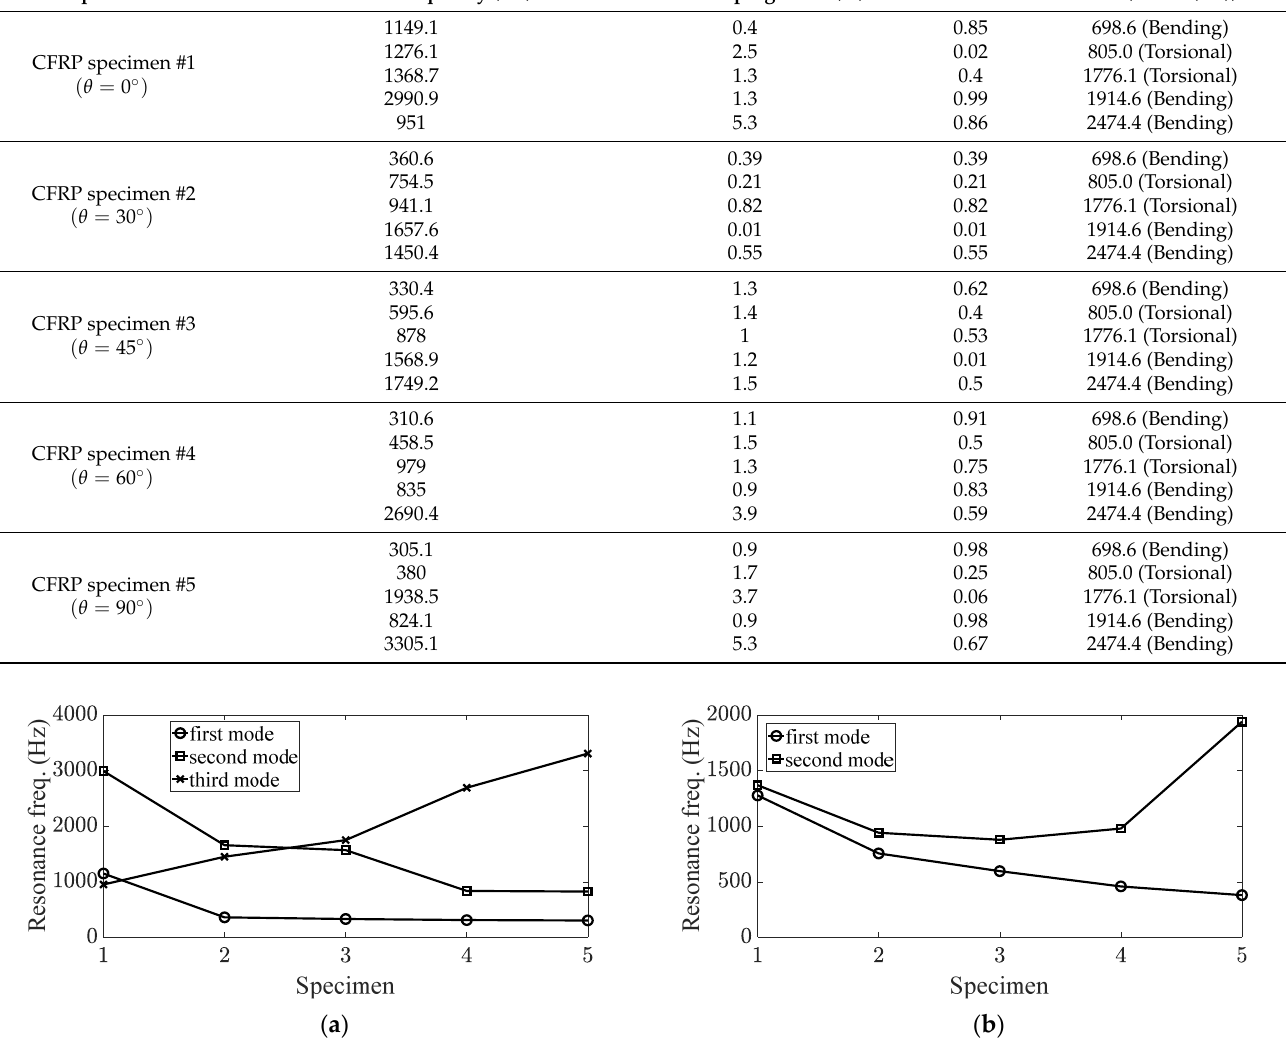
Figure 7. Variations in resonance frequencies based on carbon fiber angle: ( a ) bending modes; ( b ) torsional modes.